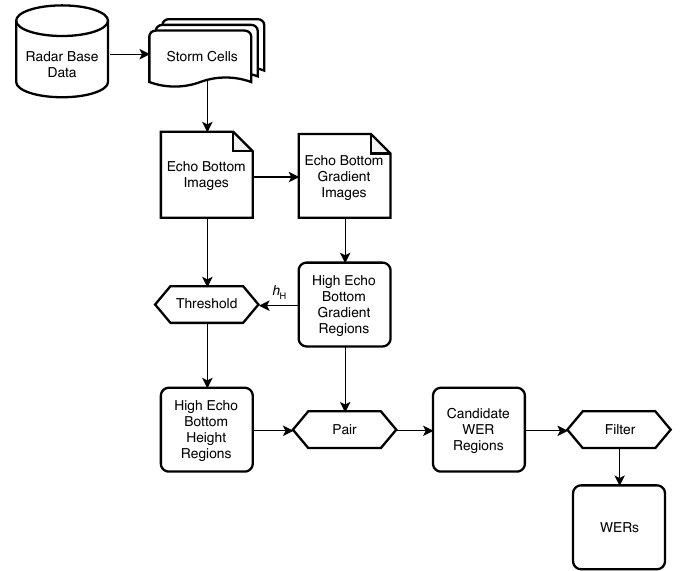
Figure 3. Flowchart describing the weak echo region (WER) detection algorithm.